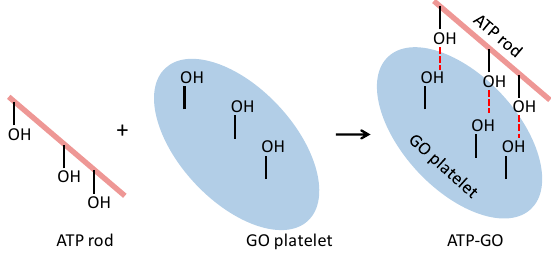
Figure 1. Illustration of the reaction between graphene oxide (GO) and attapulgite (ATP).